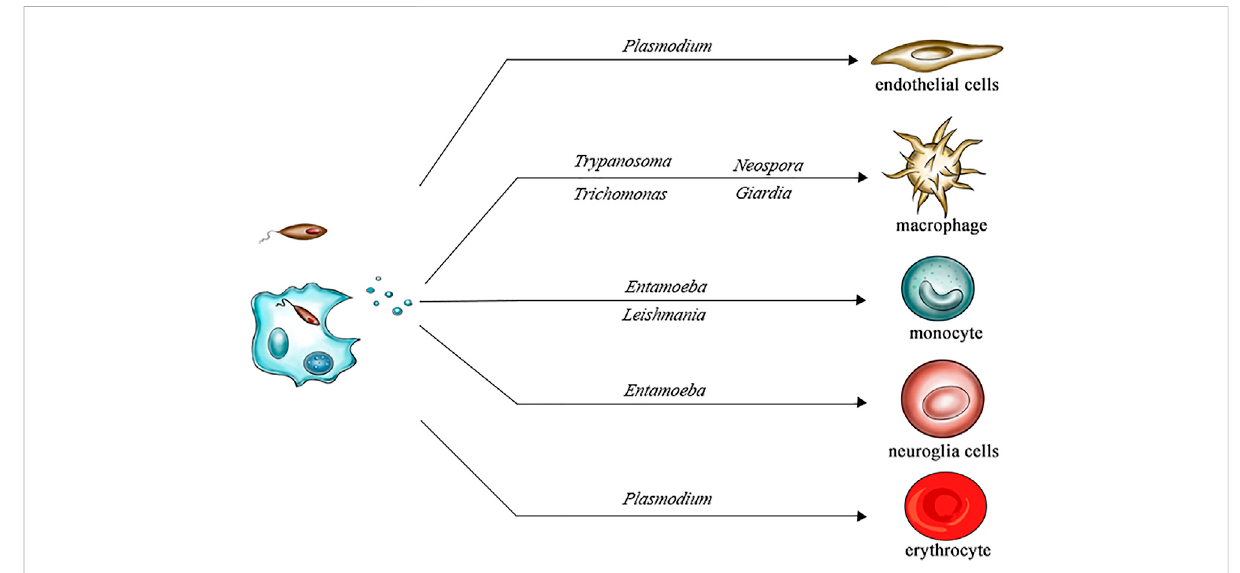
FIGURE 2 Extracellular vesicles shed by different parasites infect different